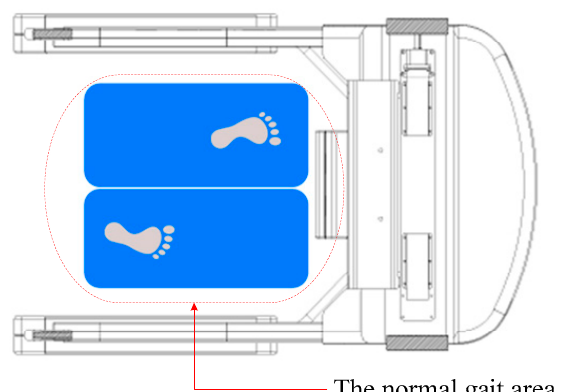
Figure 4. The spatial distribution of normal gait.